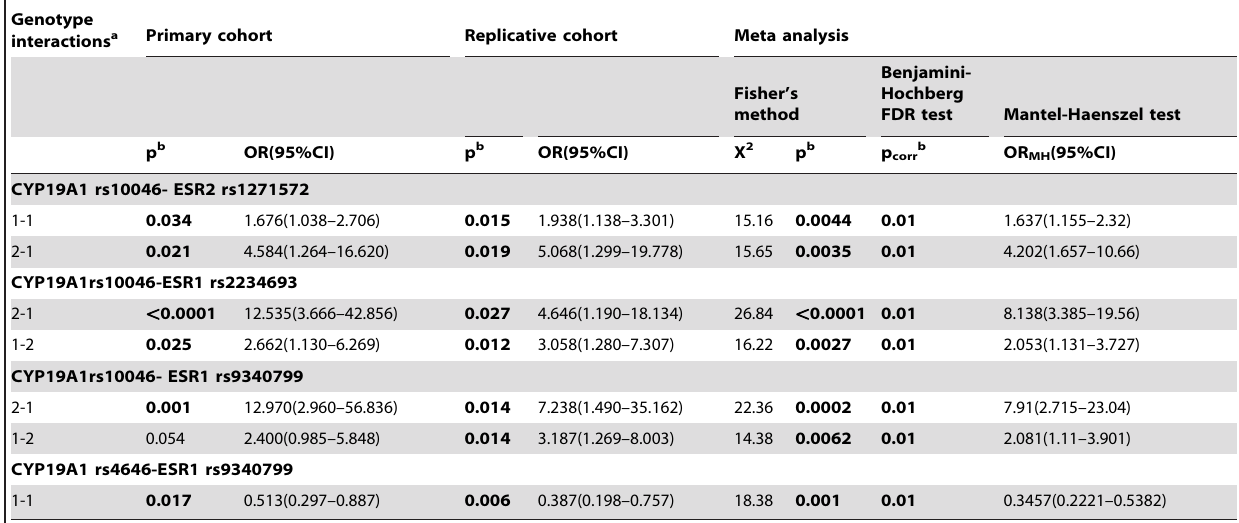
Table 5. Gene-Gene Interaction of genotypes.